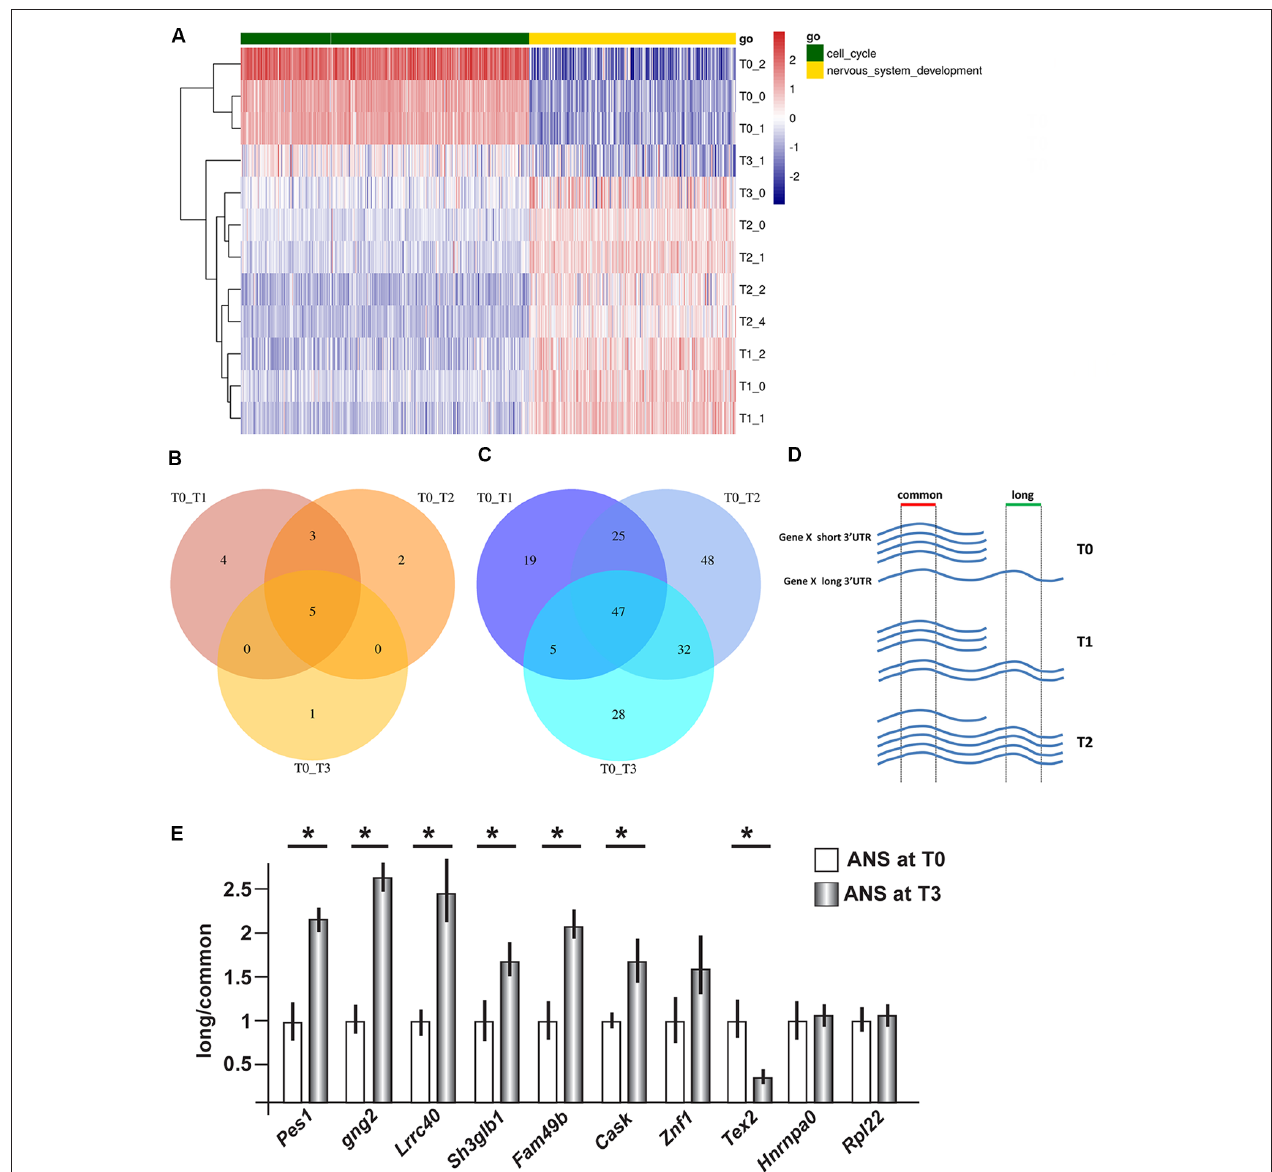
FIGURE 1 | Gene expression profiling and 3 (cid:48) untranslated region (3 (cid:48) UTR) length in differentiating adherent neural stem (ANS) cells. RNAseq data were obtained from ANS cells at T0 (proliferating), T1, T2 and T3 (three timepoints of GABAergic differentiation). (A) Cluster analyses and heat Map of differentially expressed coding mRNAs, relevant to the control of cell cycle exit (in green) and early neuronal differentiation (in yellow). The color-code of the raw Z-scores is shown on the right. (B,C) Venn diagrams summarizing the number of transcripts showing shortening (B) or lengthening (C) during inhibitory neuron differentiation, comparing proliferating (T0) with differentiating (T1, T2, T3) ANS cells. (D,E) Technical validation of 3 (cid:48) UTR lengthening. A scheme illustrating the strategy used to quantify the relative abundance of the long vs. common forms of 3 (cid:48) UTR is shown in (D) . Ten selected 3 (cid:48) UTRs were examined by Real-Time qPCR analysis (in E ). Eight of them showed changes in the relative abundance consistent with the RNAseq data. See also Supplementary Tables S3A,B for a full list. ∗ p <